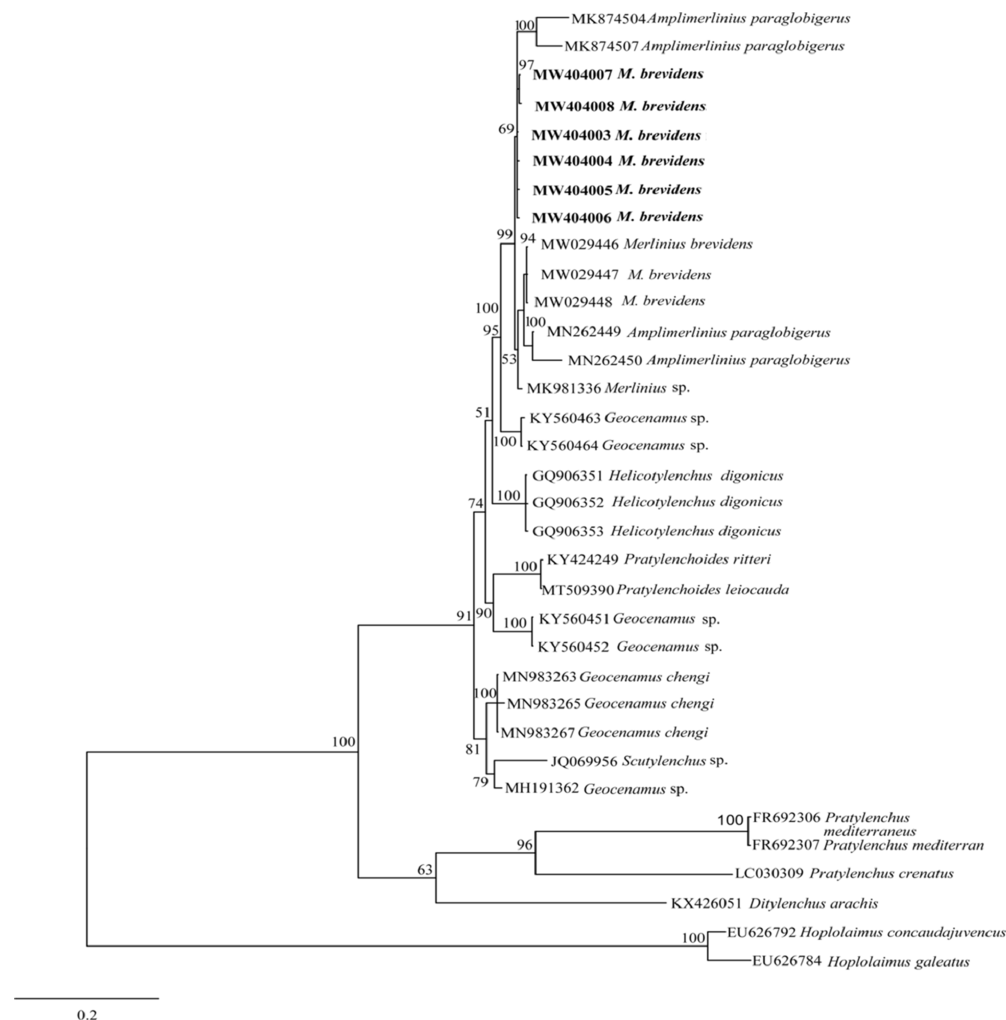
Figure 6. Bayesian tree inferred under the GTR + G + I model from sequences of ITS rRNA region of the newly sequenced species of Merliniidae indicated in bold and other tylenchids sequences. Posterior probability and bootstrap values exceeding 50% are given on appropriate clades.